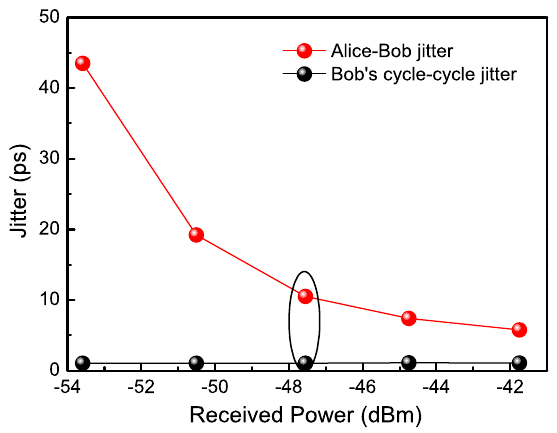
FIG. 5. Timing jitter vs received clock power measured be- tween Alice and Bob over a fiber link of 80 km. Also shown is Bob’s cycle-cycle